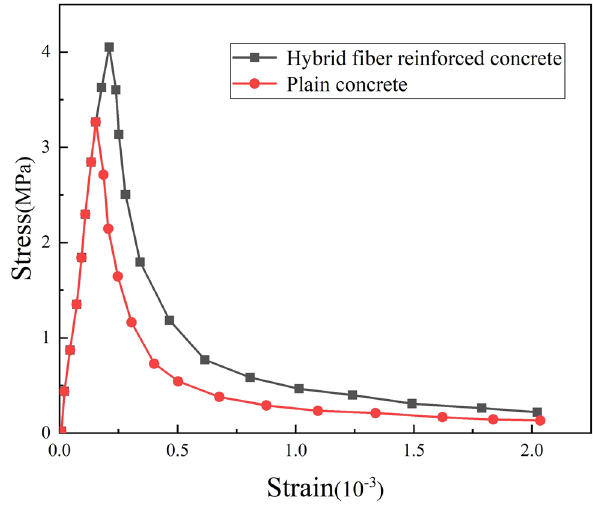
Figure 7: Stress – strain curves of plain concrete and steel – polypro - pylene